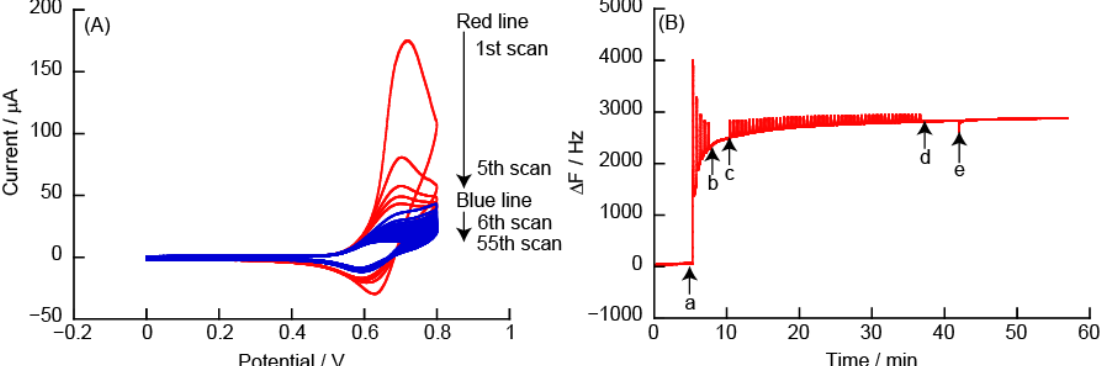
Figure 8. ( A ) Cyclic voltammograms of (PAH/TEMPO-PAA) 5 film in 10 mM HEPES (pH 7, containing 150 mM NaCl), and ( B ) changes in the resonance frequency on the Au resonator in the eQCM. The electric potential (scan rate: 50 mV/s) was applied between (a) and (b) (number of sweep scan: 5 times), or (c) and (d) (number of sweep scan: 50 times) in the eQCM. Finally, the Au resonator was exposed to 10 mM HEPES buffer (pH 7, containing 150 mM NaCl) (e).